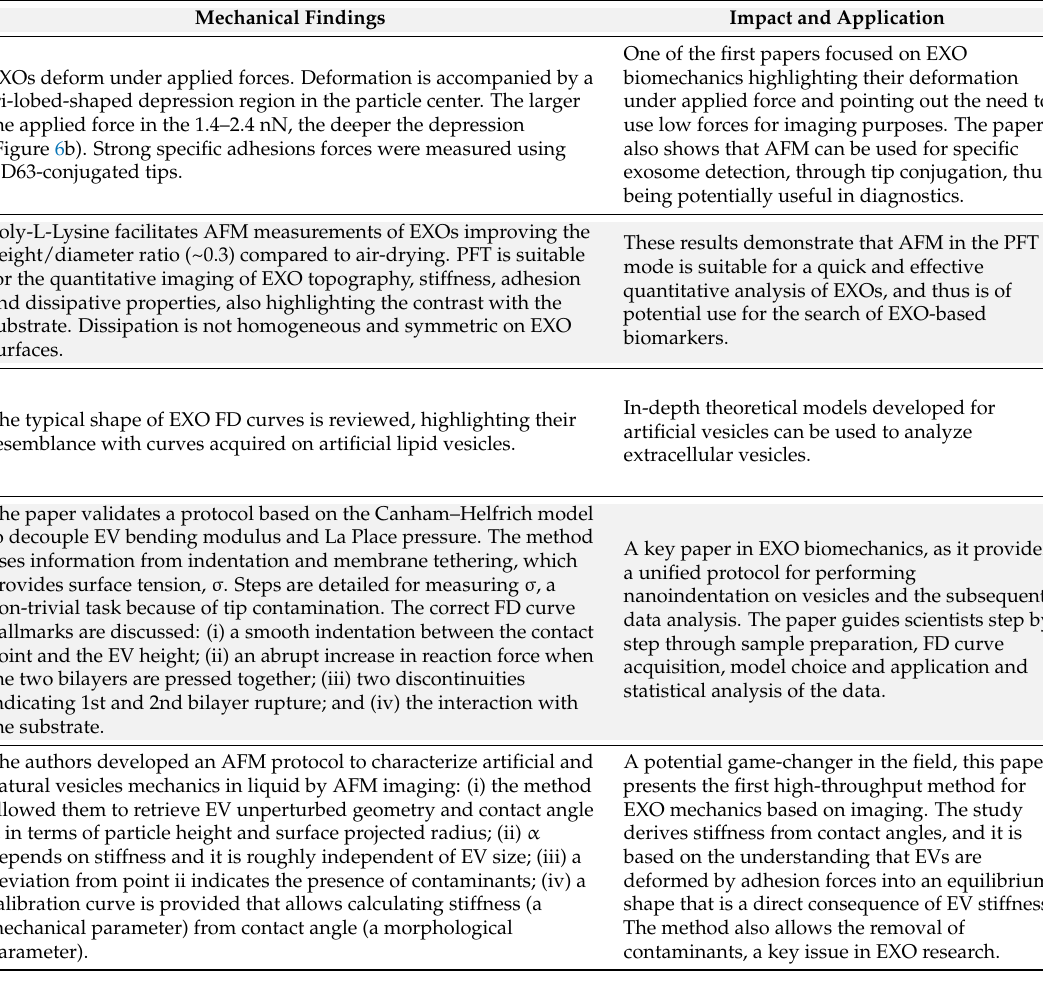
Table 5. Summary of methodological AFM papers investigating EV